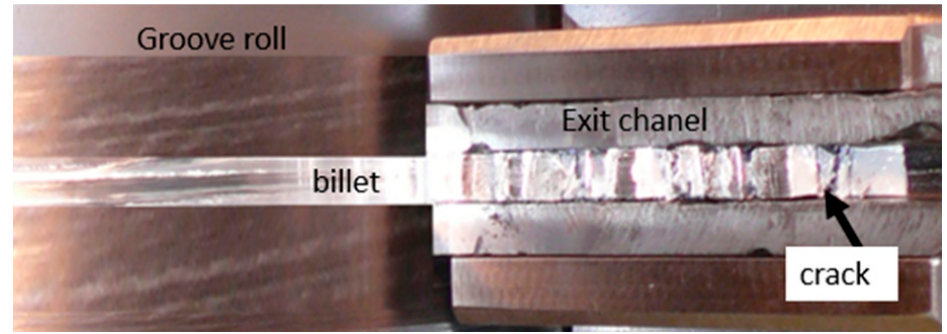
Figure 3. The billet of Alumix 321 after one ECAR pass.